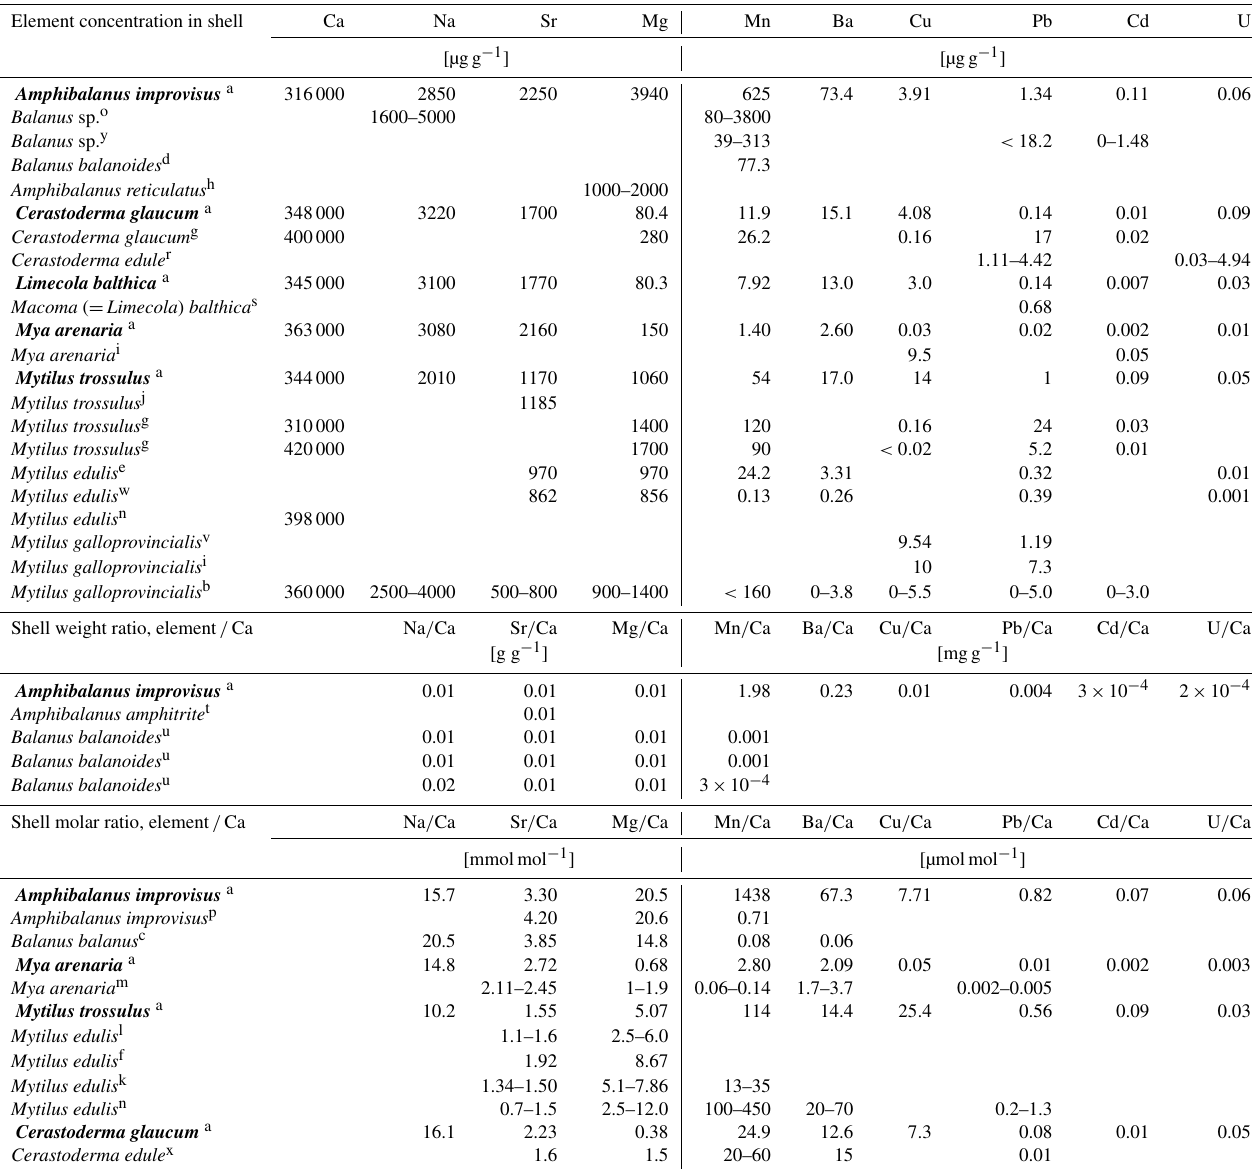
Table 4. Elemental concentrations in shells from different regions based on this study (in bold) and literature data. Element concentration in